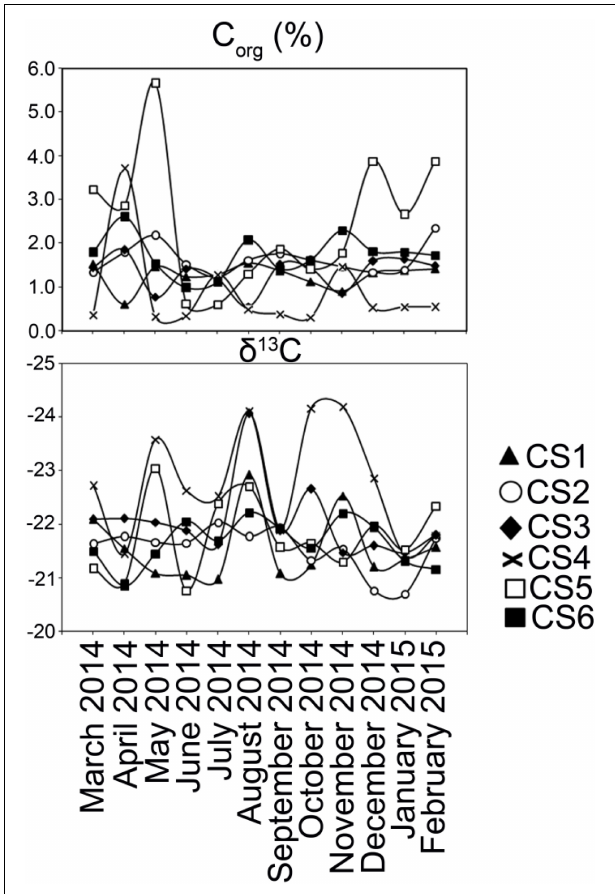
FIGURE 6 | Characterization of sedimentary organic carbon. Values of C org and δ 13 C estimated from the surface (0–2 cm) sediment column collected from each sampling station of lagoon during the study